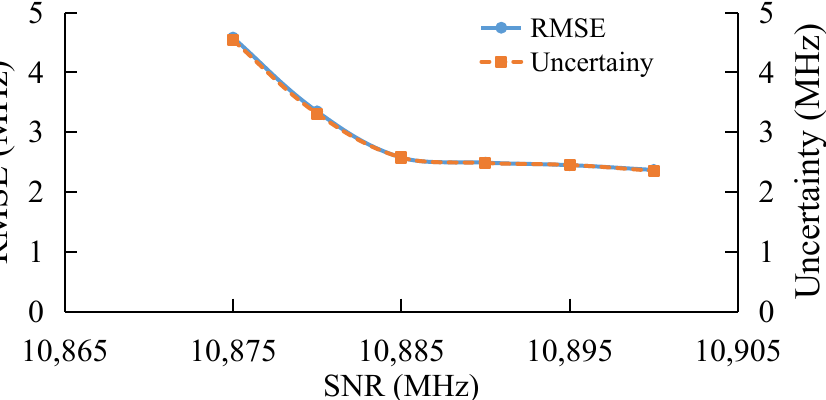
Figure 10. Experimental results under different cut-off frequency.